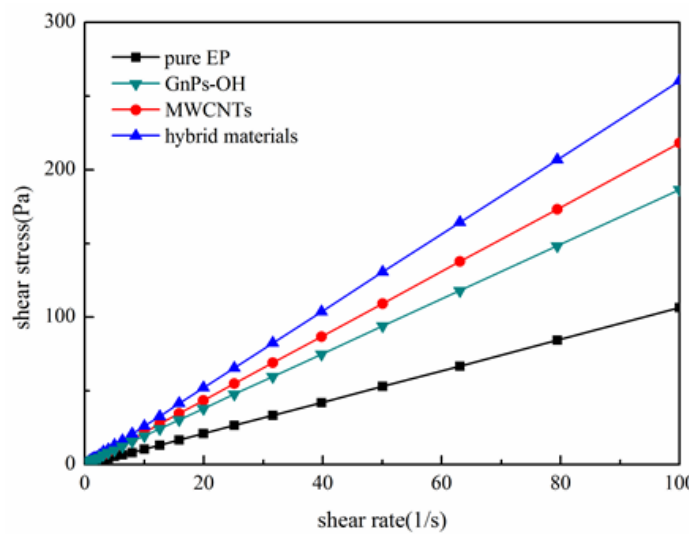
Figure 6. The shear stress vs. shear rate of epoxy and epoxy composites.